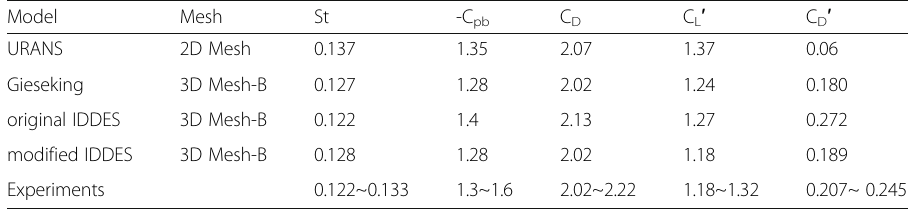
Table 3 Results obtained by URANS simulation on 2D mesh and 3D simulations on Mesh-B